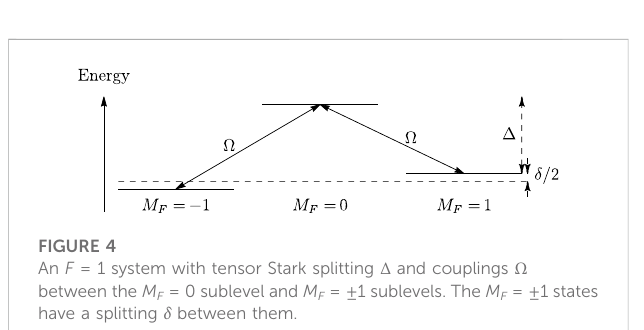
FIGURE 4 An F = 1 system with tensor Stark splitting Δ and couplings Ω between the M F = 0 sublevel and M F = ±1 sublevels. The M F = ±1 states have a splitting δ between